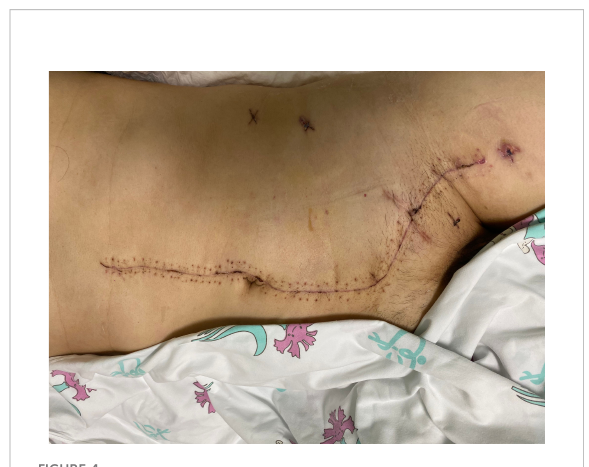
FIGURE 4 The well healed left abdominoinguinal incision.